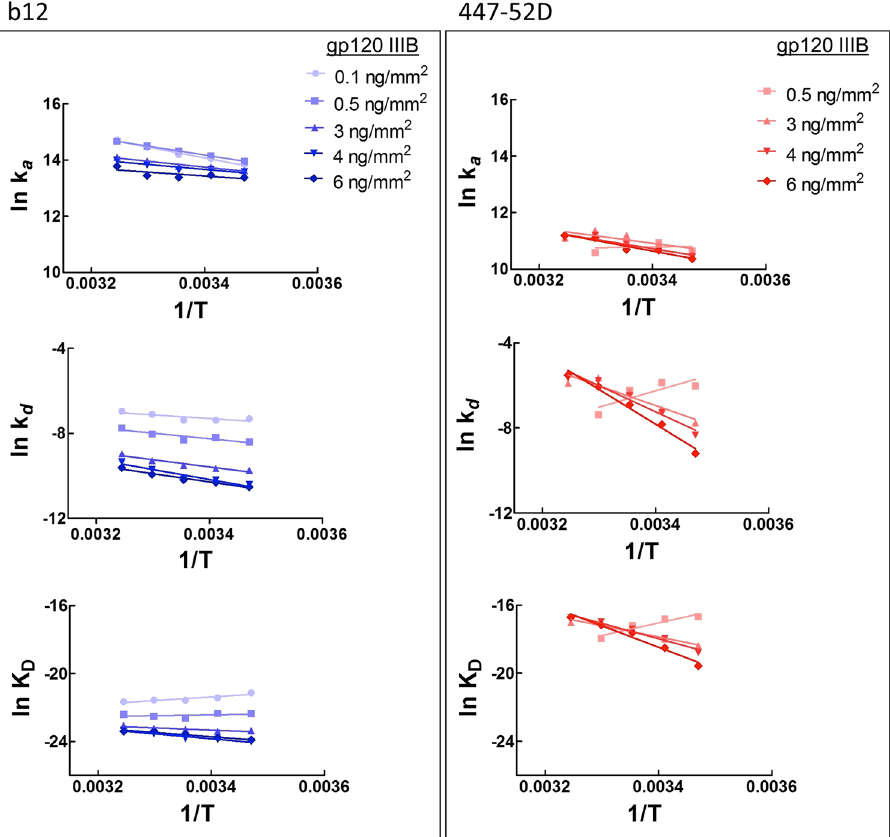
Figure 2. Temperature dependences of binding kinetics and affinity of Abs - b12 (different intensities of blue) and 447-52D (different intensities of red) for binding to various densities of immobilized gp120. The plots were generated by linear regression analyses. The Arrhenius plots were generated by linear regression analyses. Values of R 2 of the presented fits are as follows: (1) b12, k a , 0.1 ng/mm 2 : 0.9857, 0.5 ng/mm 2 : 0.9997, 3 ng/mm 2 : 0.9596, 4 ng/mm 2 : 0.8657, 6 ng/mm 2 : 0.5564; k d , 0.1 ng/mm 2 : 0.6644, 0.5 ng/mm 2 : 0.8049, 3 ng/mm 2 : 0.9374, 4 ng/mm 2 : 0.9175, 6 ng/mm 2 : 0.9721; K D , 0.1 ng/mm 2 : 0.8475, 0.5 ng/mm 2 : 0.1463, 3 ng/mm 2 : 0.7897, 4 ng/mm 2 : 0.9423, 6 ng/mm 2 : 0.9417. (2) 447-52D, k a , 0.5 ng/mm 2 : 0.01112, 3 ng/mm 2 : 0.6398, 4 ng/mm 2 : 0.8680, 6 ng/ mm 2 : 0.9407; k d , 0.5 ng/mm 2 : 0.6886, 3 ng/mm 2 : 0.8773, 4 ng/mm 2 : 0.9506, 6 ng/mm 2 : 0.9801; K D , 0.5 ng/mm 2 : 0.8916, 3 ng/mm 2 : 0.9502, 4 ng/mm 2 : 0.9644, 6 ng/mm 2 :